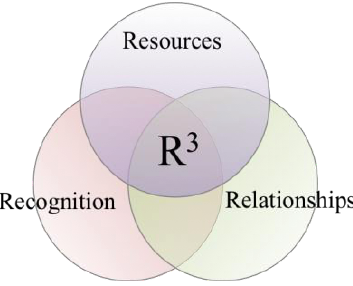
Figure 1. Interactive Model of Resources, Recognition, and Relationships.